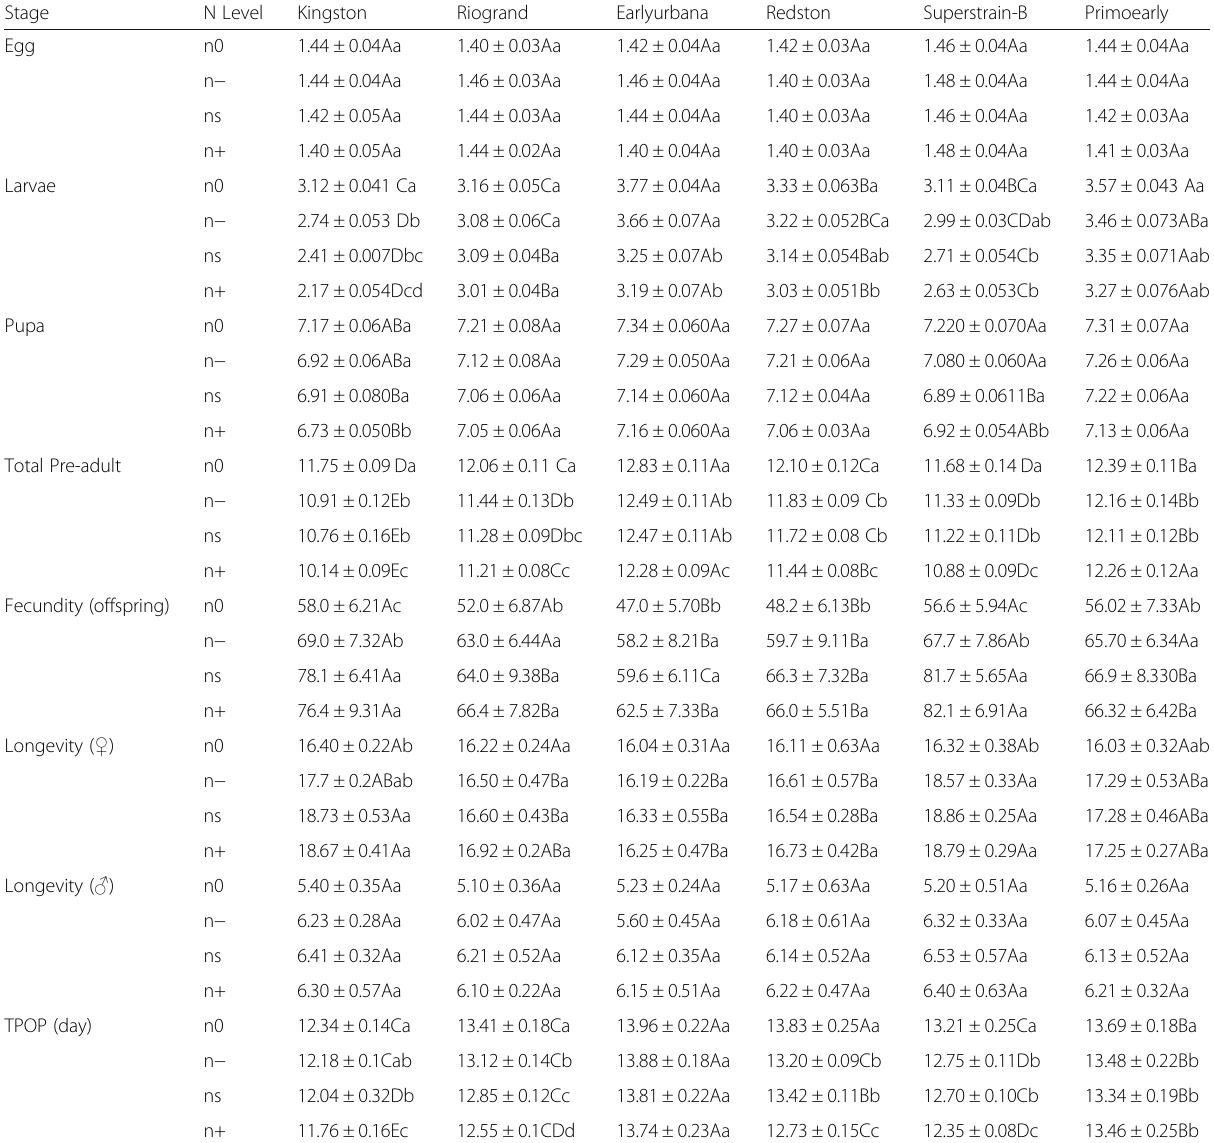
Table 3 The mean (± SE) pre-adult longevity, adult longevity, pre-oviposition periods (days) and total pre-oviposition period